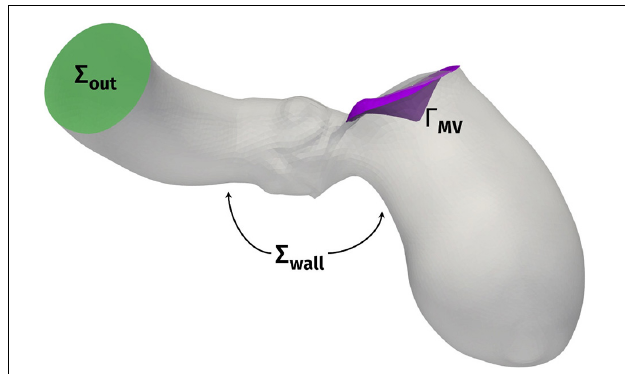
FIGURE 2 | Computational domain (cid:127) with its outlet section (cid:54) out and the endocardial and aortic walls (cid:54) wall . (cid:48) MV denotes the mitral valve leaflets.